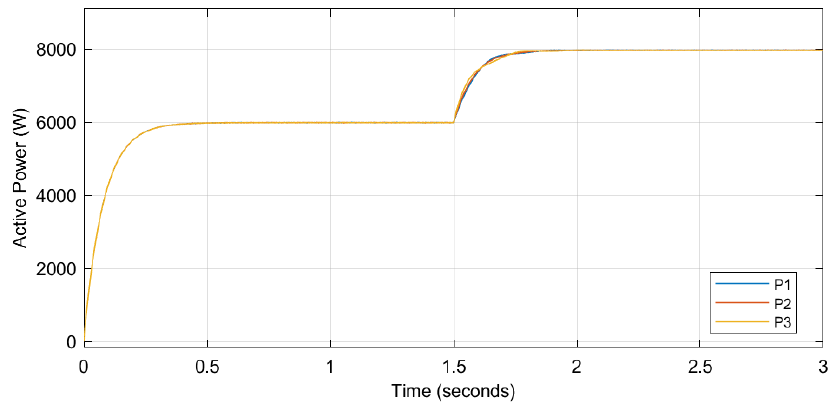
Figure 11. Active power output of the droop controller with typical virtual impedance.